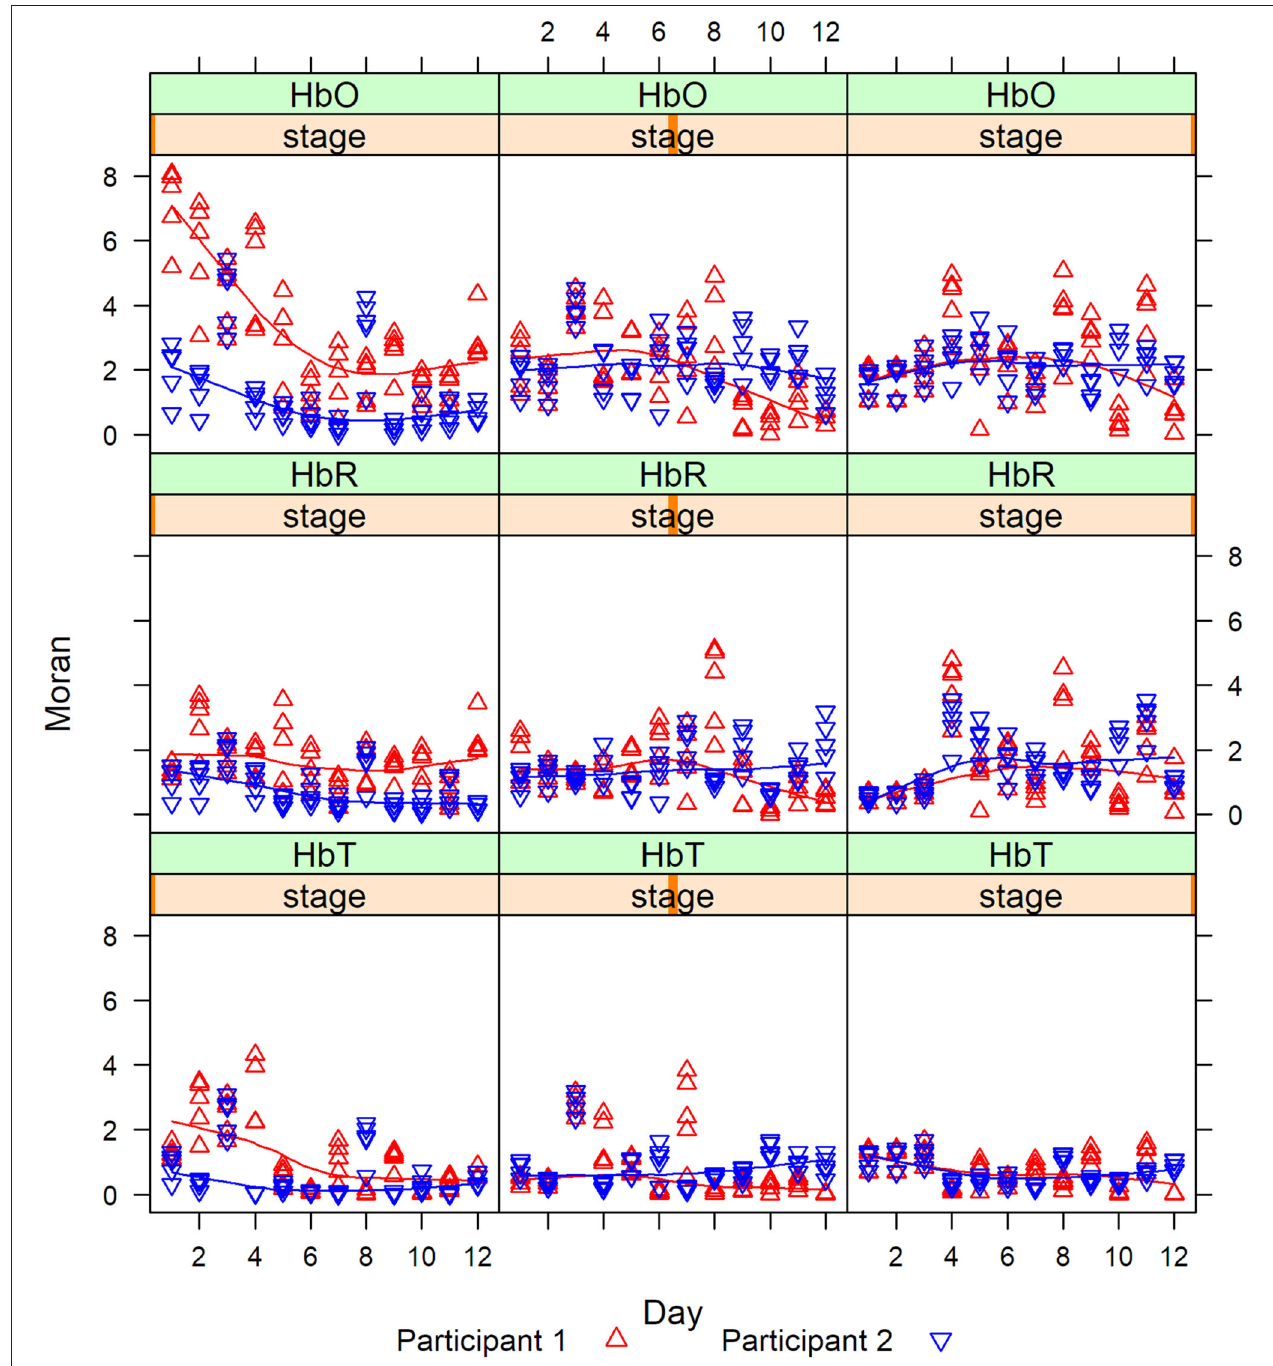
FIGURE 8 | Moran statistic for Grouping 1 for HbO, HbR, and HbT by stage for days 1–12.